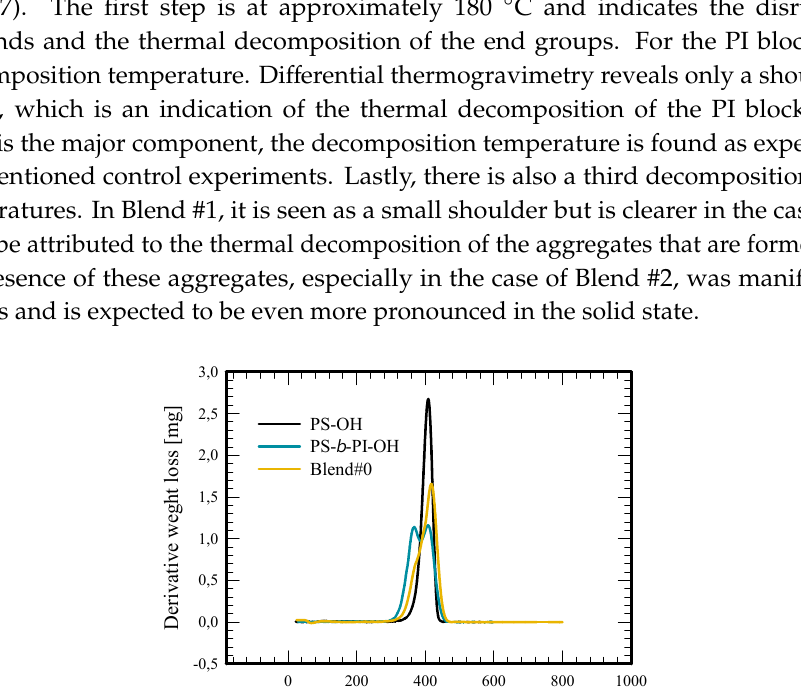
Table 6. DSC results for the end ‐ functionalized polymers and blends. Sample